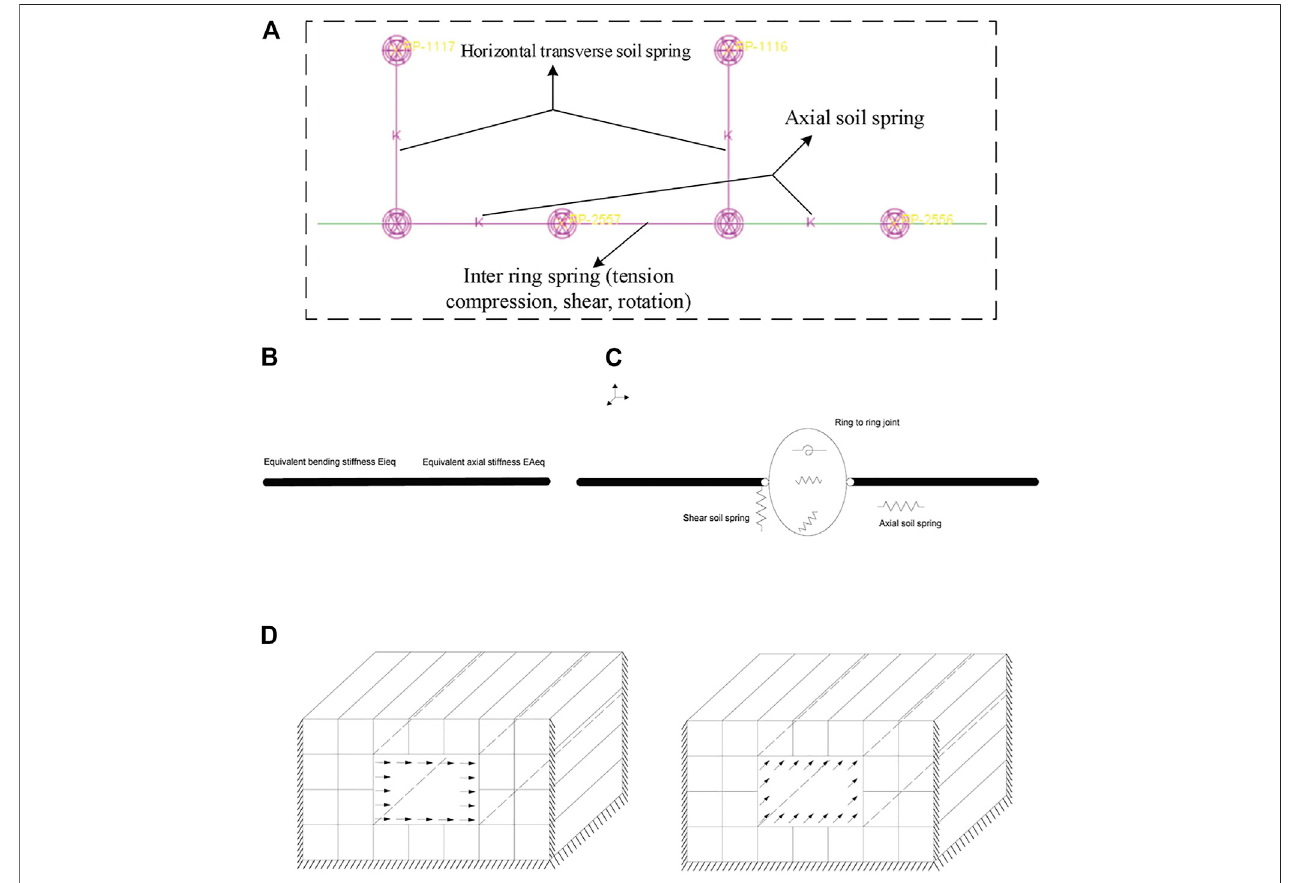
FIGURE5 |(A) Theoverall model ofthe shield tunnel, themodel of thering joints; (B) Theequivalent stiffness model; (C) Thebeam-spring model and (D) calculate the base bed coef fi cient model.